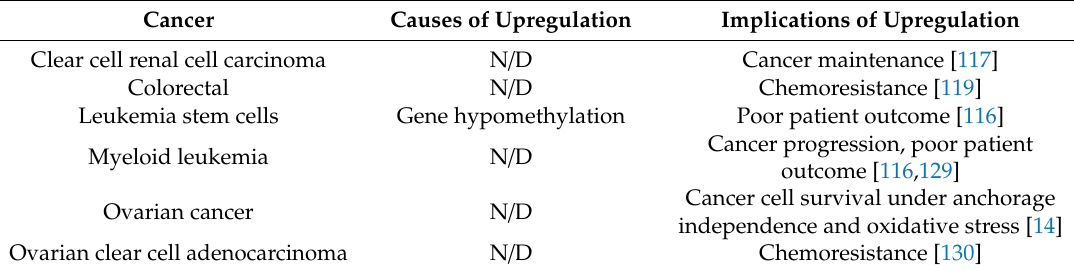
Table 2. Examples of studies demonstrating increased GPx3 expression in tumor tissues, and implications of GPx3